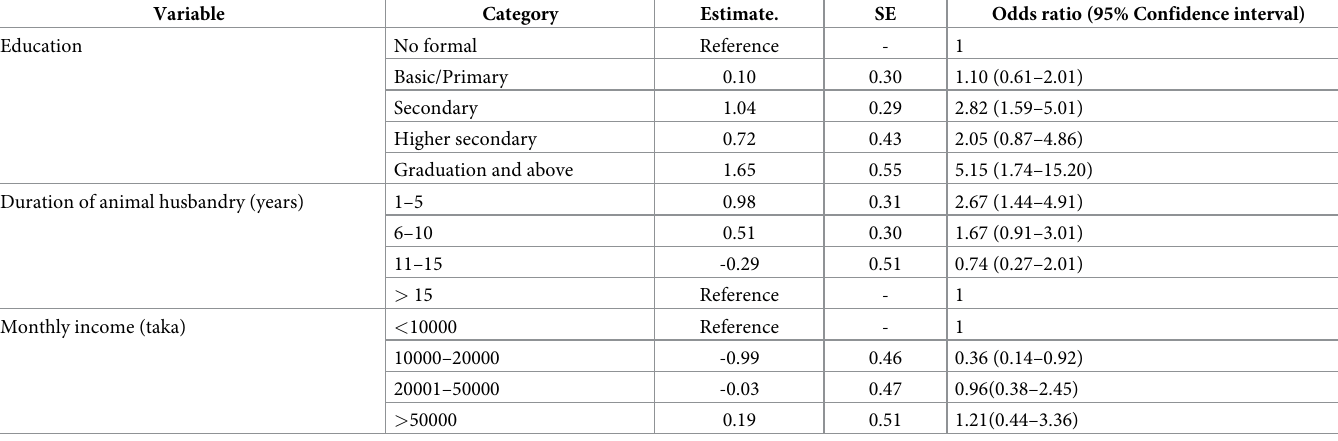
Table 4. Predictors of cattle handler’s overall knowledge with respect to zoonotic tuberculosis in the final multivariable logistic regression model. Variable Category